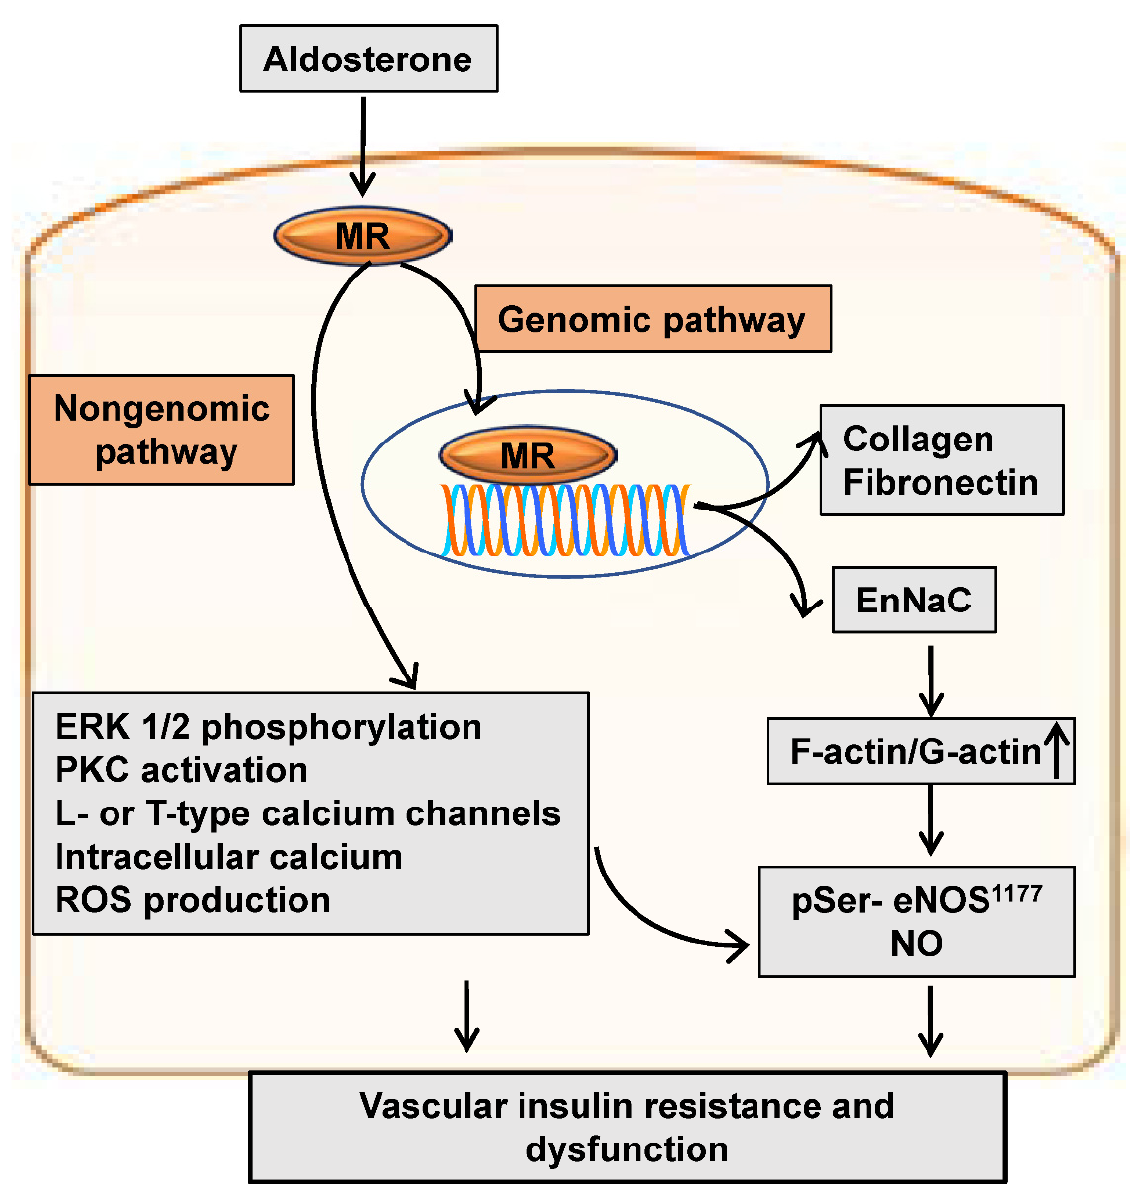
Figure 1. Enhanced mineralocorticoid receptor signaling induces vascular insulin resistance and dysfunction through genomic and nongenomic pathways. Arrow represents a process in vascular insulin resistance. MR: Mineralocorticoid receptor; ERK 1/2: Extracellular receptor kinase 1/2; PKC: Protein kinase C; ROS: Reactive oxygen species; NO: Nitric oxide; eNOS: Endothelial NO synthase.